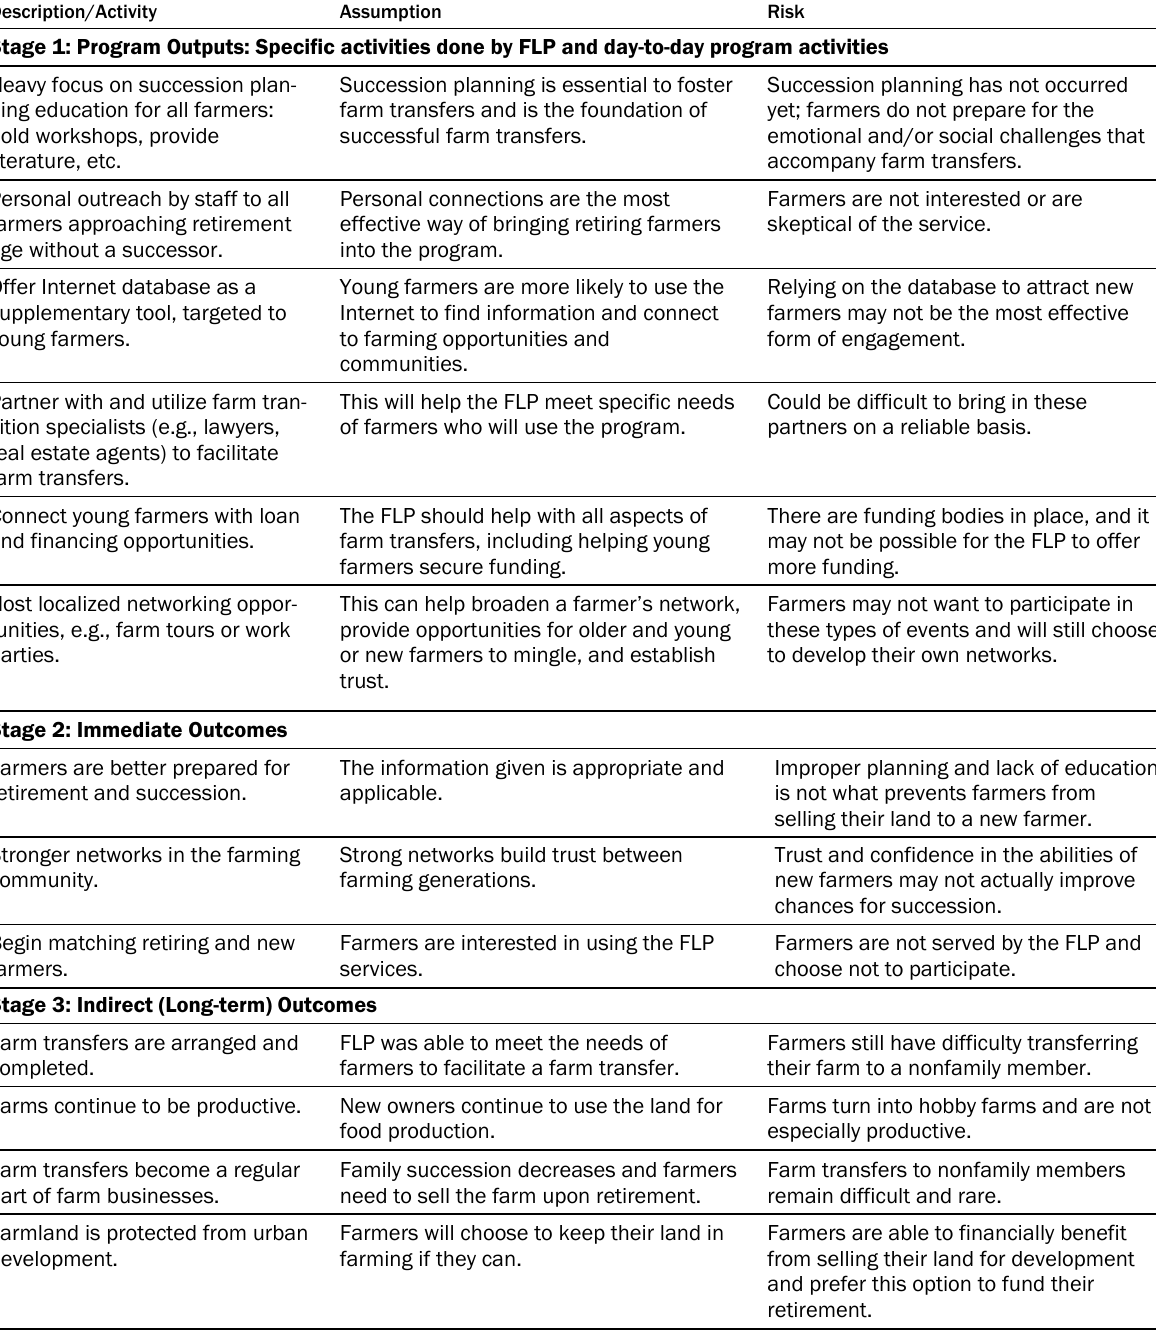
Table 5. Revised Theory of Change for a Farm Link Program (FLP)